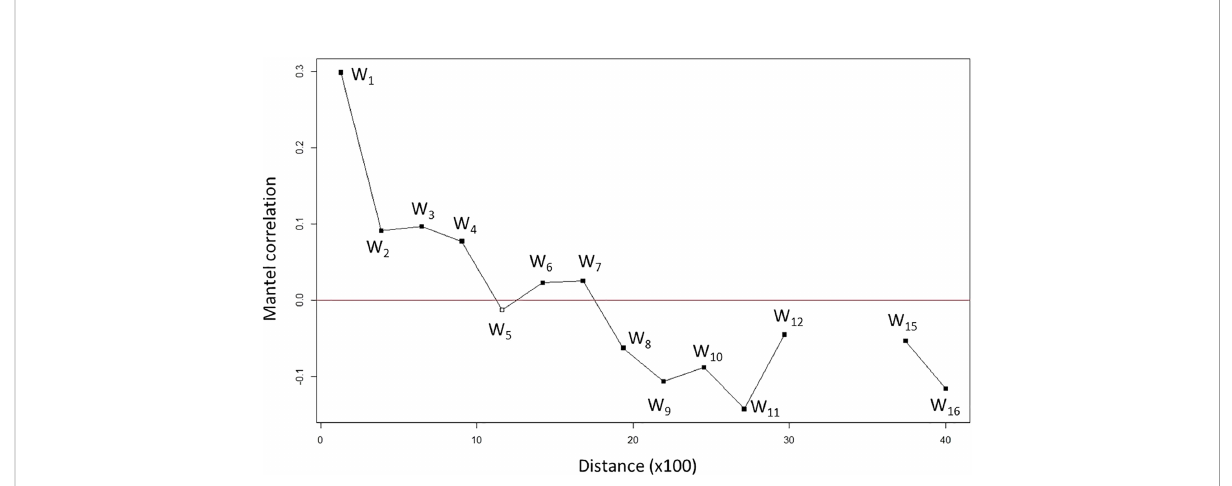
FIGURE 1 Genetic divergence increased (correlation decreased) along with the geographic distances of nipa populations across IWP. The plot is generated by a Mantel correlogram indicating distance (×100) in kilometers. For example, 10 means 1,000 km apart. Black solid squares show signi fi cant correlation while a white empty square shows no signi fi cance in correlation value. Each distance class is labeled as W k ( k = 1 to 16 with 13 – 14 no